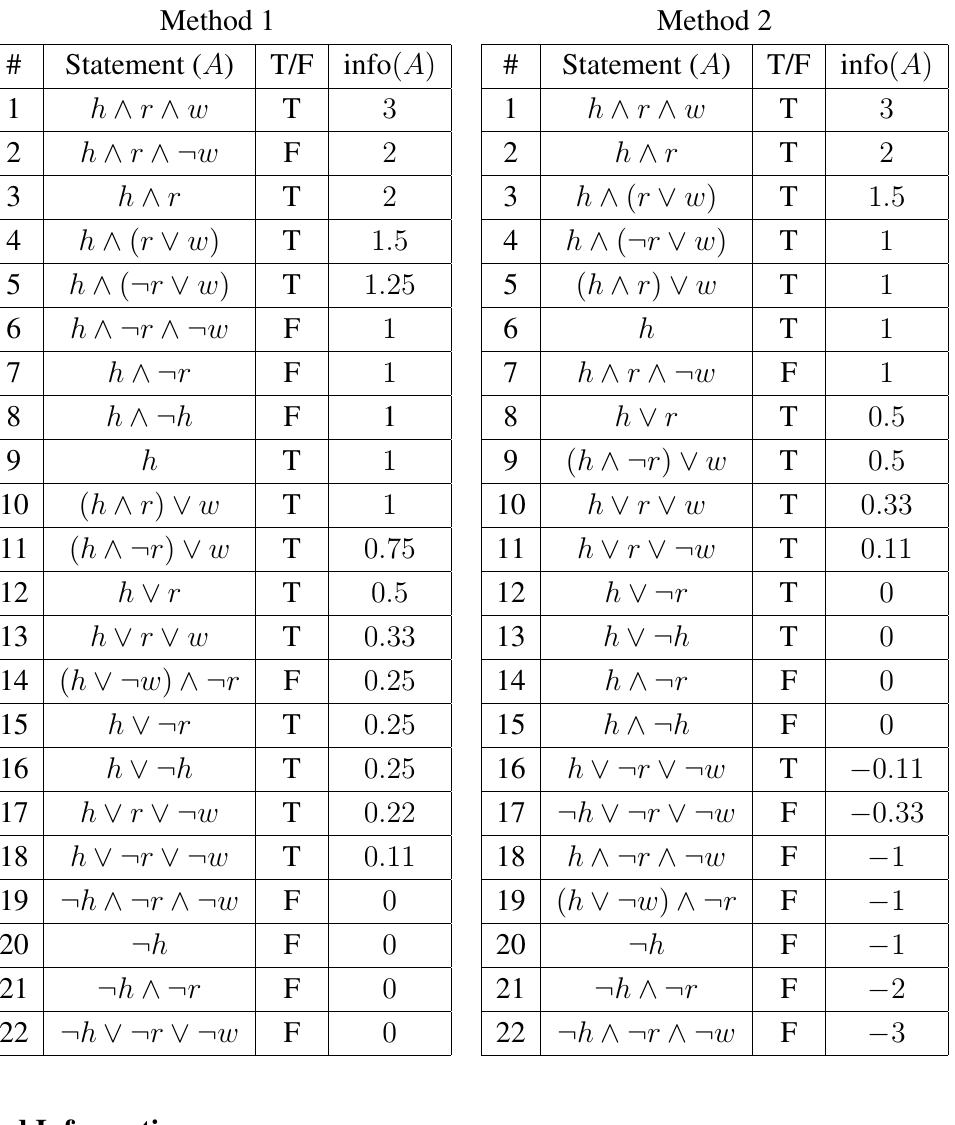
Table 13. Information yield using formula-based